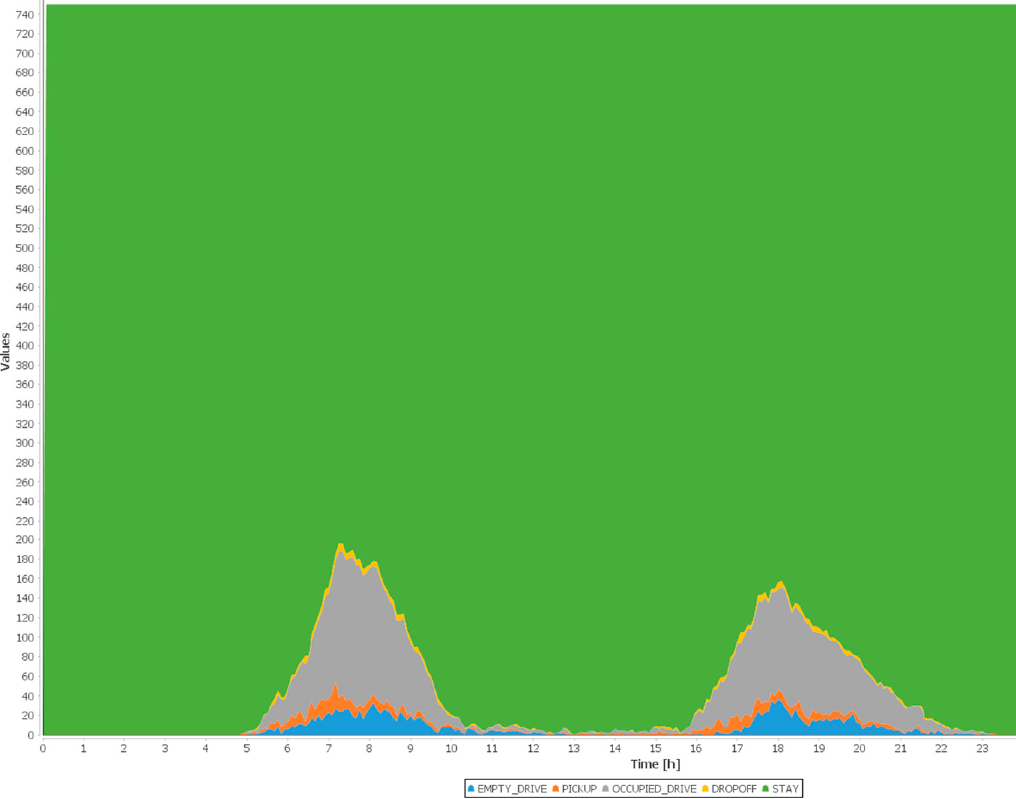
Figure 5. Time profile of 750 AVs, when the AVs replaced conventional cars in scenario (4).